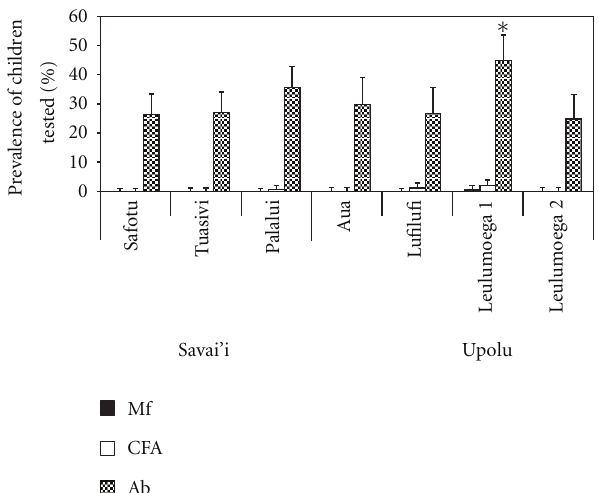
Figure 5: Mf, CFA, and antibody prevalence in children ≤ 10 years only across the health districts in Samoa. Similar to the data across all ages groups, Upolu had a significantly higher CFA prevalence in children than Savai’i ( χ 2 = 4 . 086; df = 1; P = 0 . 043). No di ff erences for Mf prevalence were observed between the two island groups ( χ 2 = 1 . 514; df = 1; P = 0 . 218). Similarly, no significant di ff erences for Mf prevalence were observed among the health districts ( χ 2 = 10 . 694; df = 6; P = 0 . 098), since Mf positive children were identified only in Leulumoega 1. Complementing this result, Leulumoega 1 recorded a significantly higher antibody (Ab) prevalence ( ∗ ) than the other districts ( χ 2 = 20 . 6; df = 6; P < 0 . 001). The health districts of Aua, Leulumoega 2, Safotu, and Tuasivi recorded no CFA positive children. There were no significant di ff erences for CFA prevalence in children among the health districts ( χ 2 = 2 . 612; df = 2; P = 0 . 271).